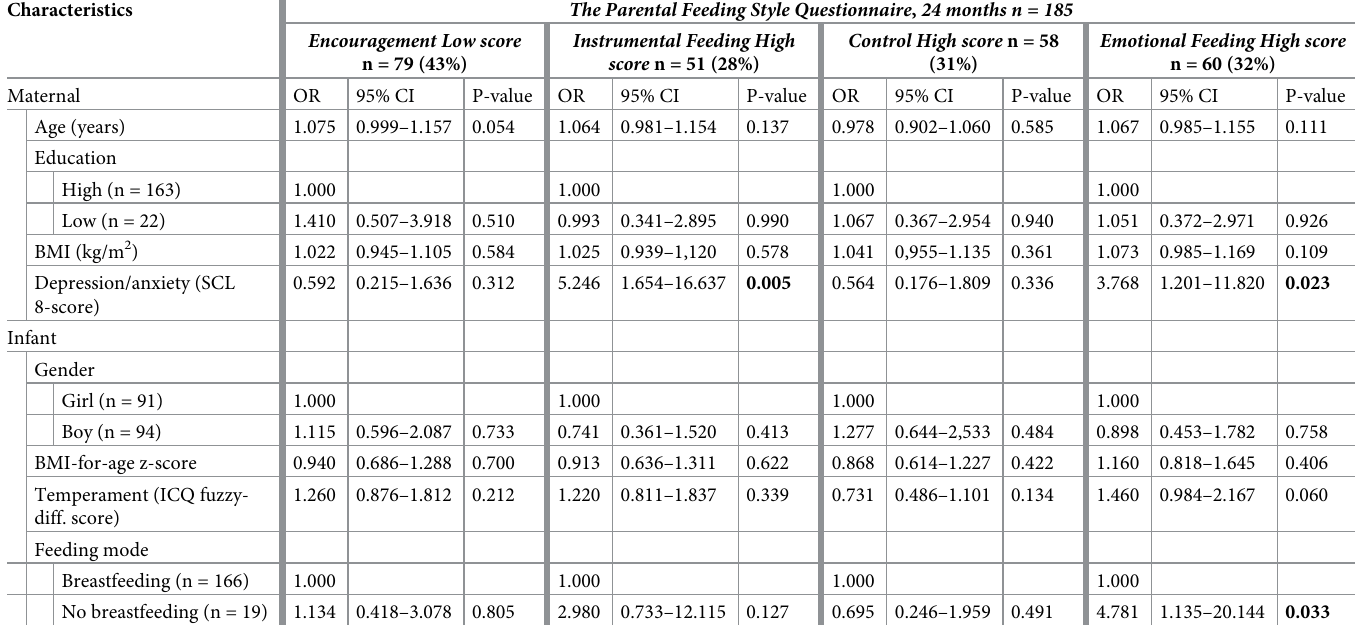
Table 5. Associations between maternal and child covariates at child age 5 months and maternal feeding styles at child age 24 months estimated by multivariable logistic